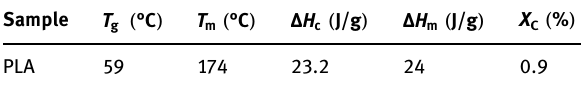
Table 2: DSC results of dynamic scanning Sample